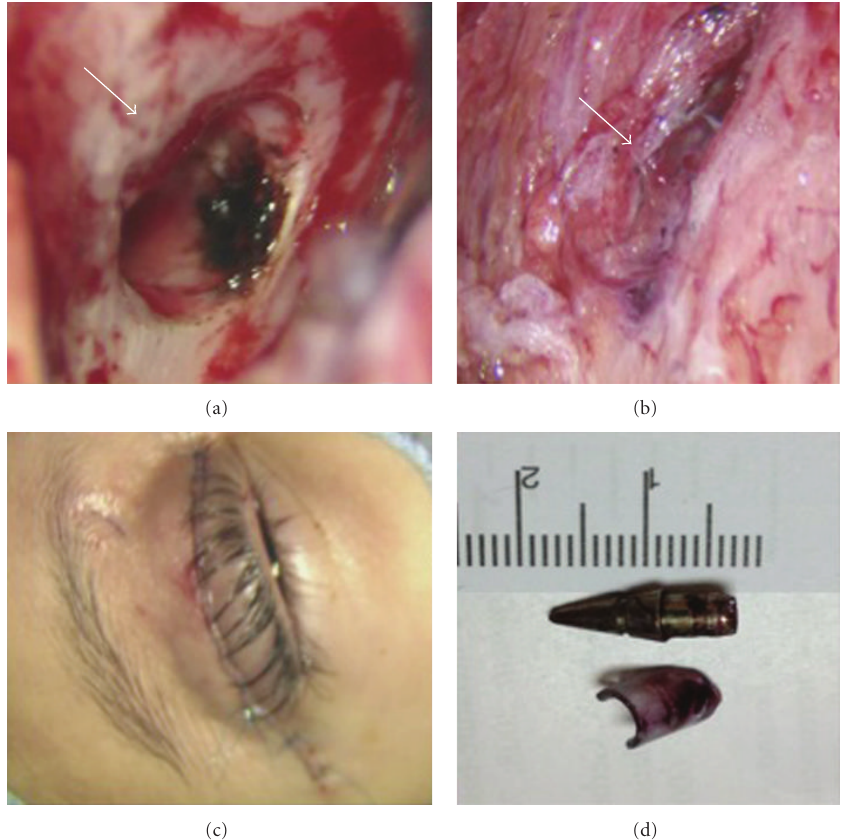
Figure 3: Intraoperative photographs demonstrating the following. (a) The site of orbital roof defect caused by the penetrating foreign body (arrow). (b) The penetrating wound at the orbital muscles and the pen ink (arrow). (c) The surgical approach (transeyelid) site after closure. (d) The penetrating pen’s tip and the piece of glass from the pen shaft.